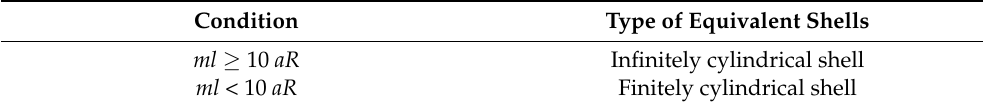
Table 3. Criteria for type of analytical